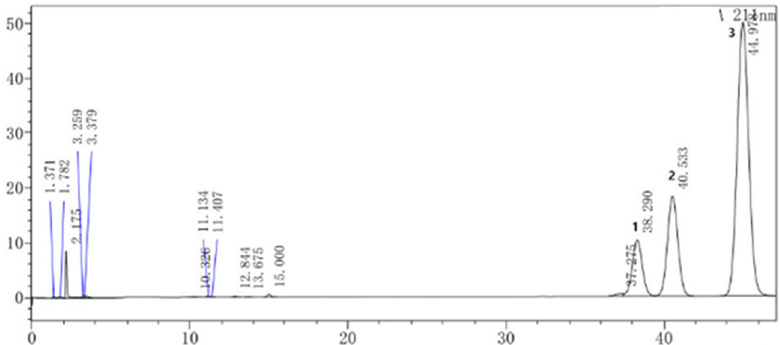
Figure 1. Structures of compounds 1 – 5 . 11(13)-dihydrotelekin ( 1 ), 4(15)- β -epoxyisotelekin ( 2 ), carabrone ( 3 ), telekin ( 4 ) and one aldehyde, 2-(3 ′ ,4 ′ -dihydroxyphenyl)-1,3-benzodioxole-5-aldehyde ( 5 ).